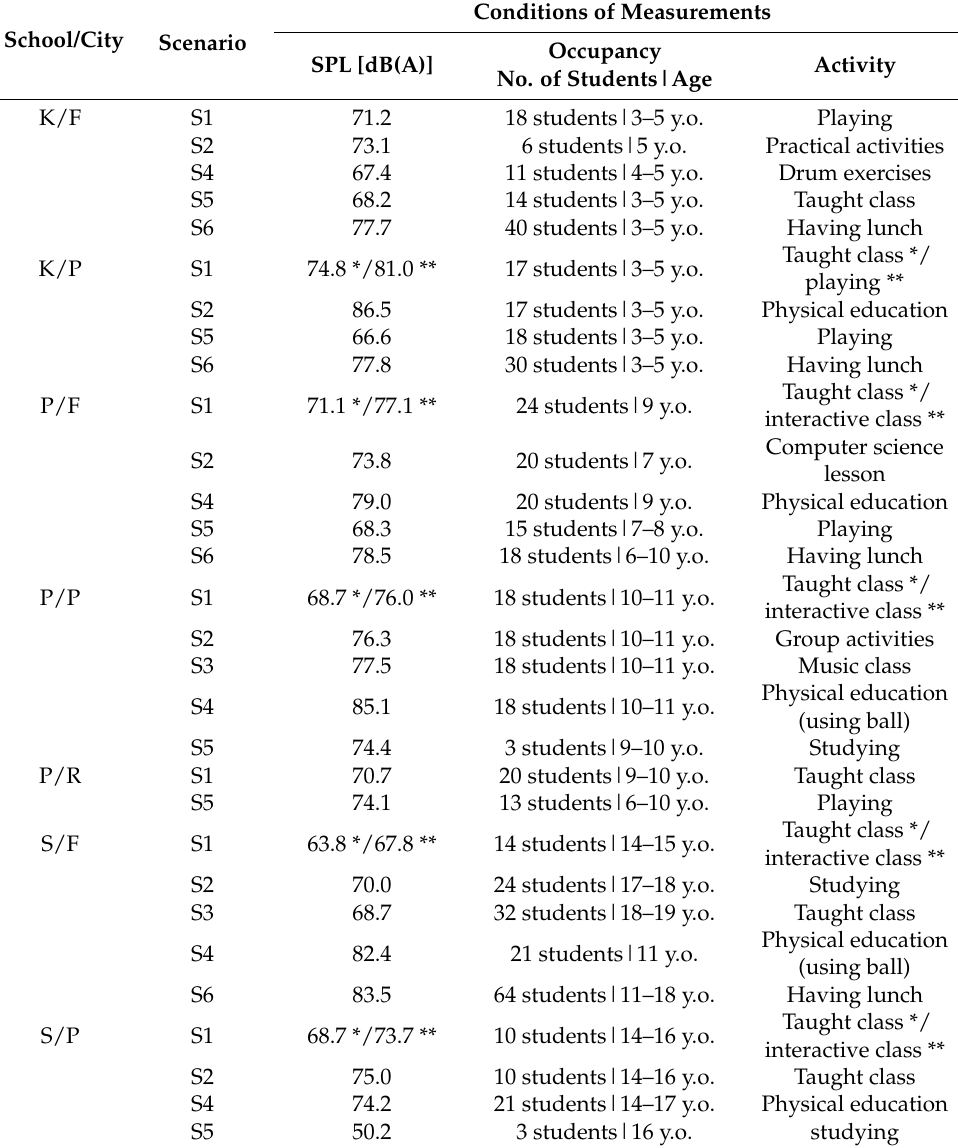
Table 4. Results of the acoustic measurements in occupied environments for the case study schools (SPL, occupancy of the room and activity carried